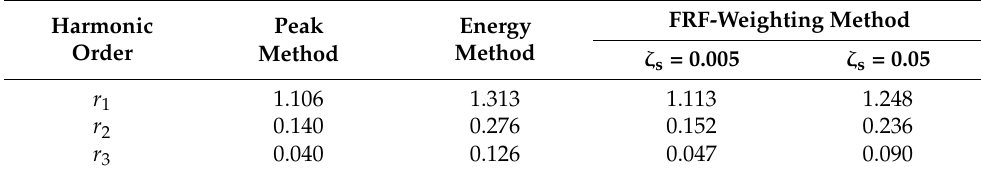
Figure 1. Fourier amplitude spectrum of a 2.0 Hz individual jumping load. Table 1. Values of the DLF obtained by different methods.